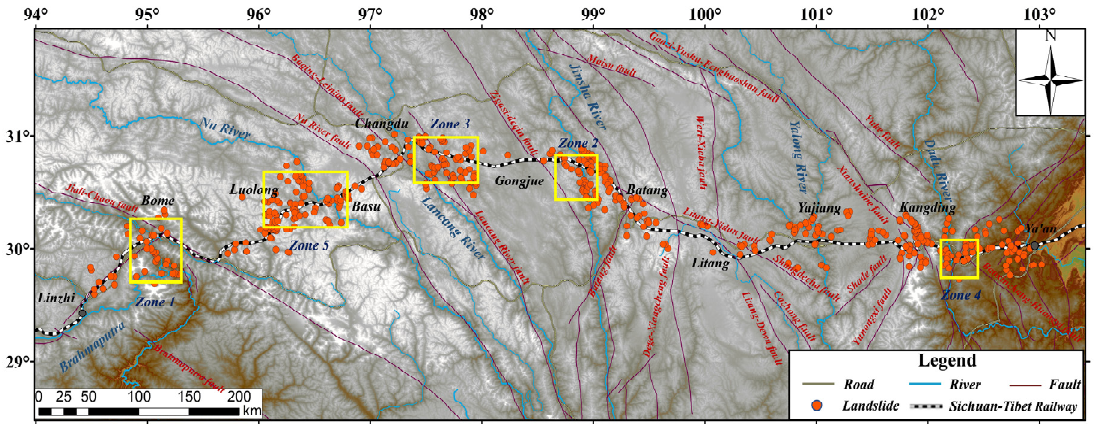
Figure 8. Inventory map of active landslides along the Sichuan ‒ Tibet Railway.